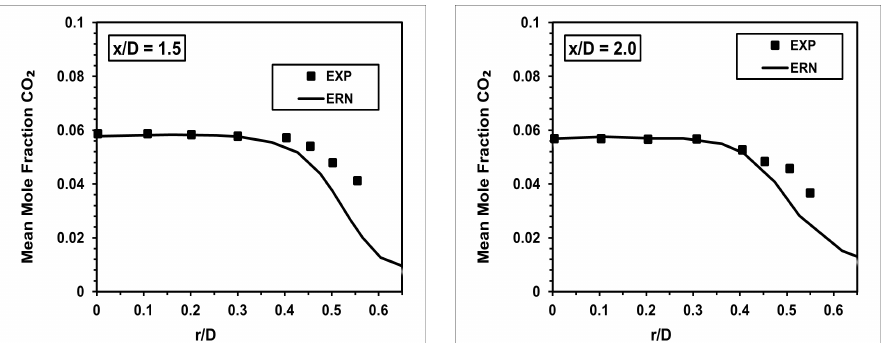
Figure 9. The computed mean CO 2 mole fraction is compared to the experimental measurements at axial locations x / D : 0.1, 0.3, 0.6, 1, 1.5, and 2.